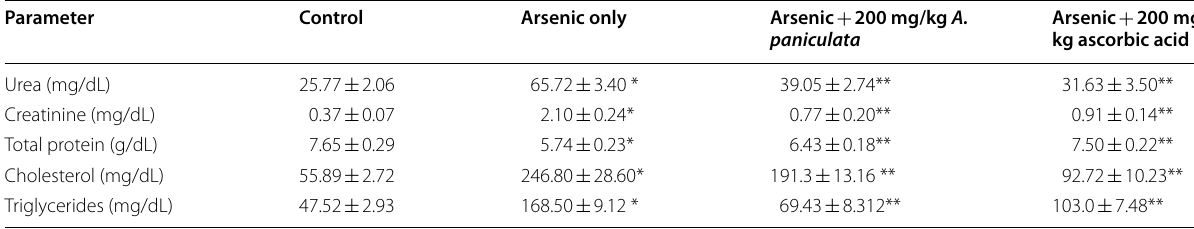
Values are mean